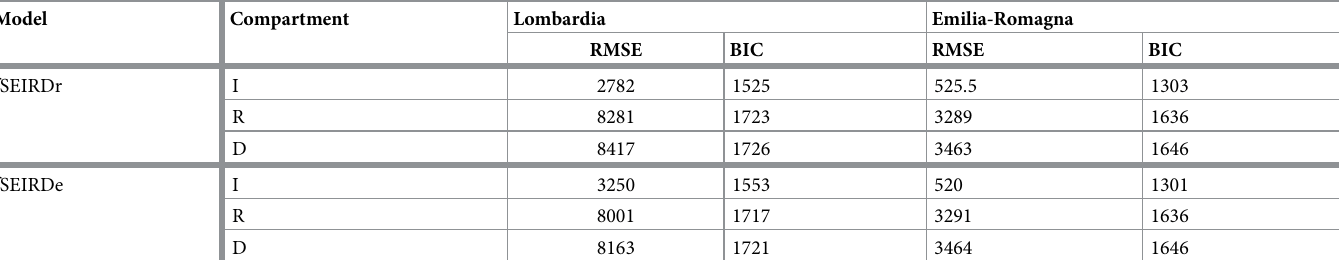
Table 2. RMSE and BIC values.